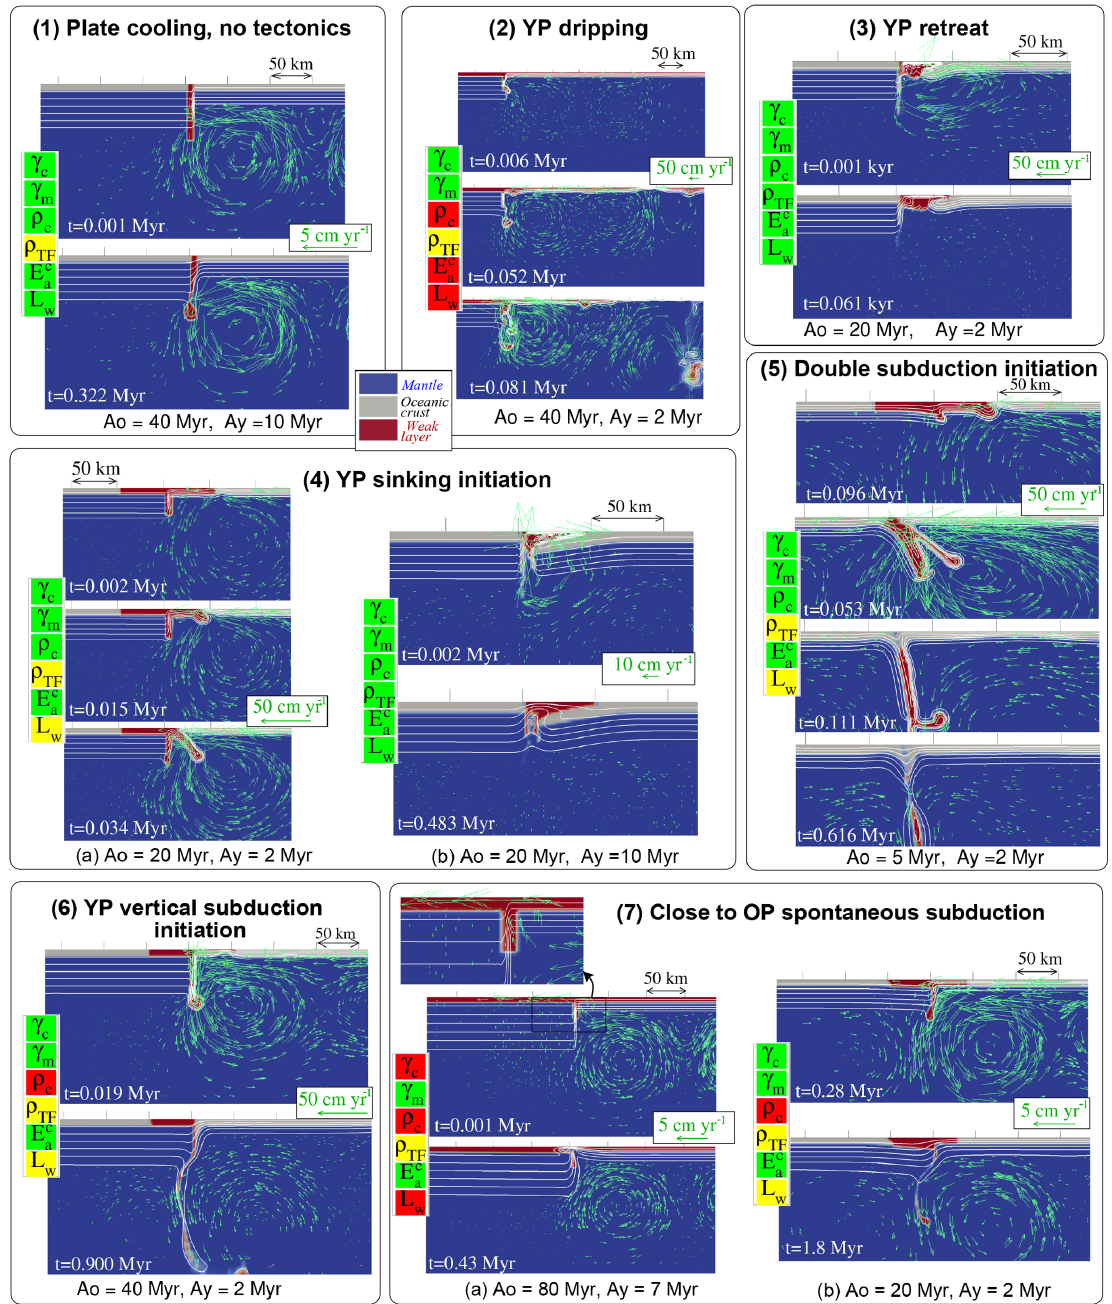
Figure 4. Illustration of the different simulated behaviors, OPS apart: close-up on the transform fault. (1) Absence of plate deformation (simulation S37x, Table 3). (2) Young plate dripping and dismantlement (simulation S17f). (3) YP retreat (simulation S16c). (4) Initiation of YP transient sinking (simulation S16b, panel a , and simulation S36b, panel b ). (5) Simultaneous initiation of YP and OP sinking pro- cesses (simulation S14n). (6) Initiation of YP vertical subduction at the TF (simulation S17o). (7) OP sinking initiation that soon aborts (simulation S33a, panel a , and simulation S16a, panel b ). No vertical exaggeration. The velocity scale depicted in green is specific to each simulation. The parameter boxes are color coded as a function of the investigated ranges depicted in Fig.